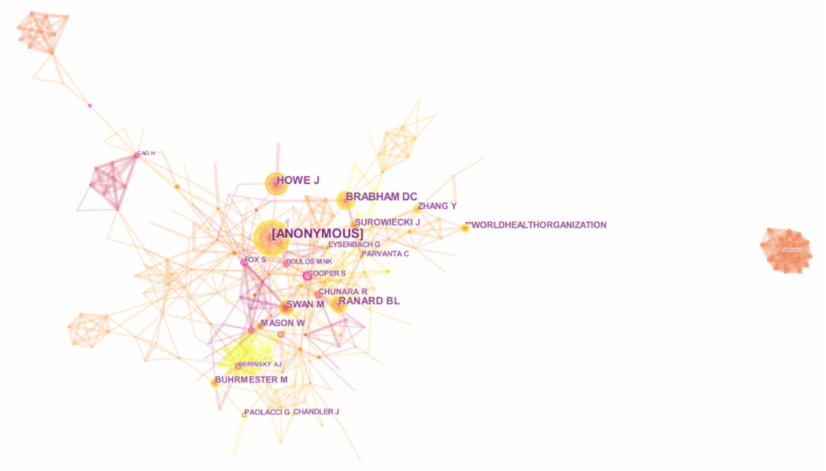
Figure 4. Map of co-authors collaboration